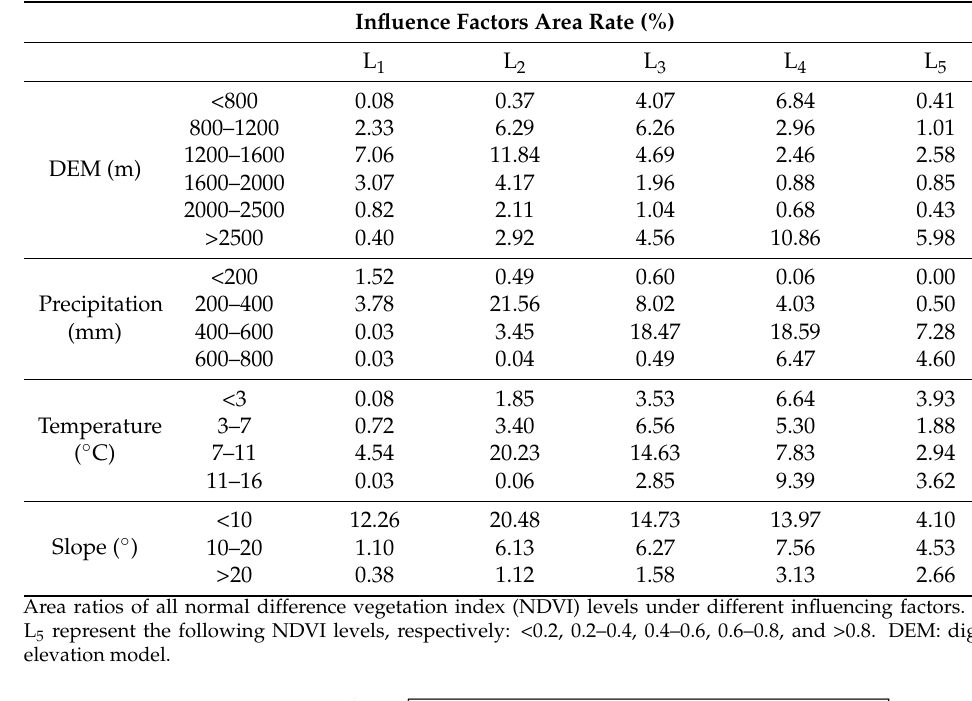
Table 3. Area ratios of all NDVI levels under different influencing factors.